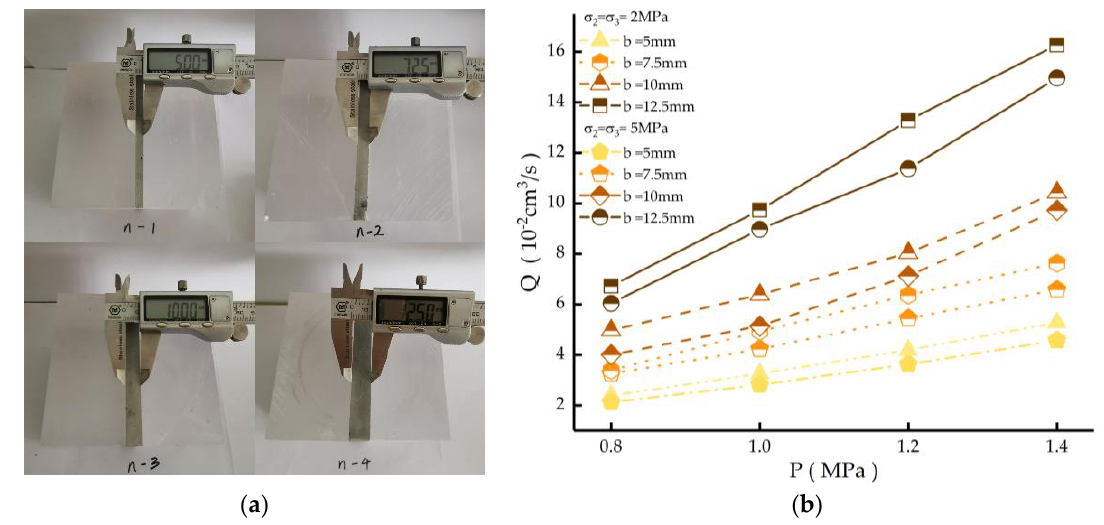
Figure 6. Rock-like specimens and flow curve: ( a ) fracture aperture of the specimens; ( b ) curve of the seepage discharge of the specimens.